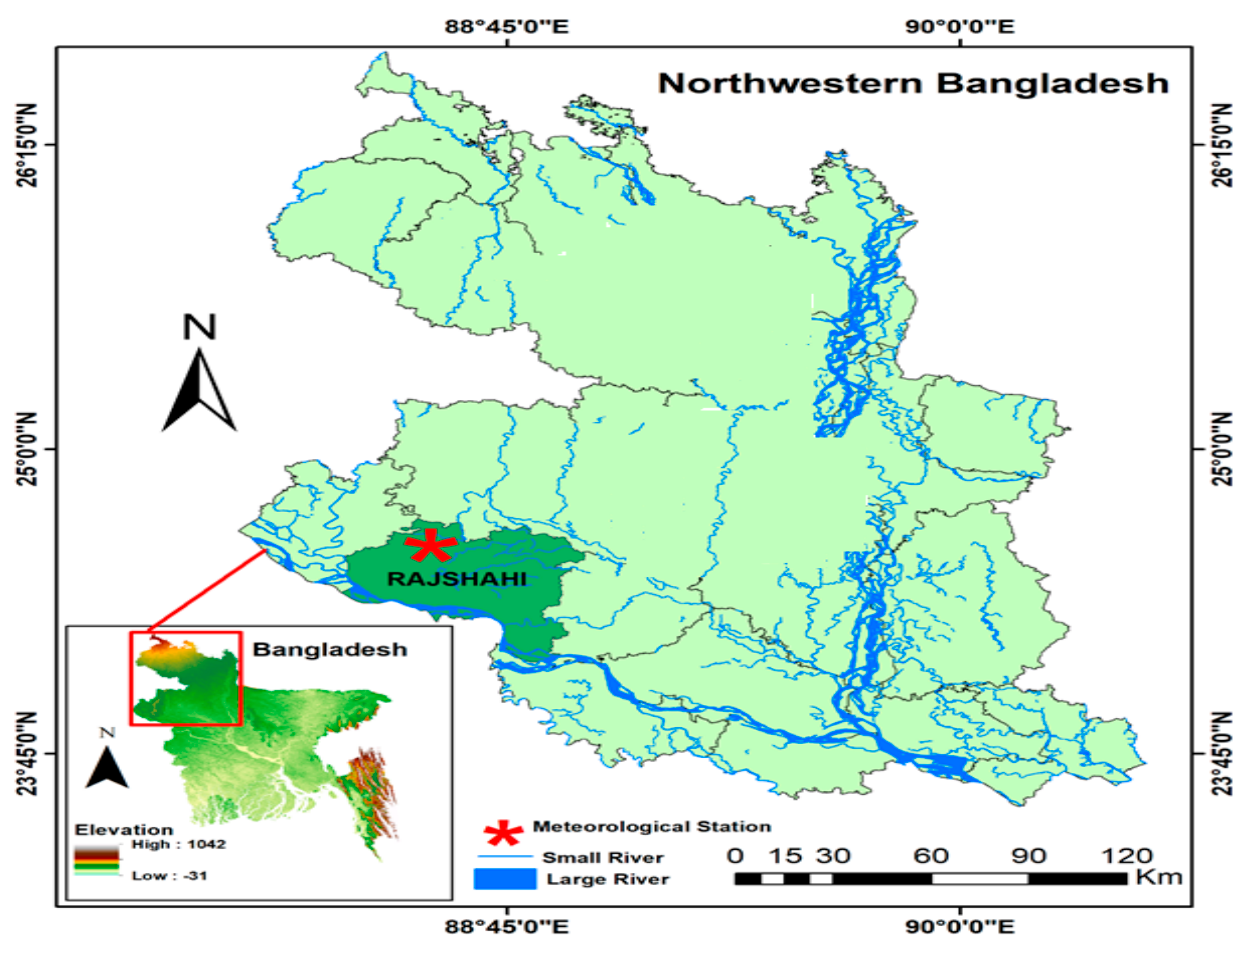
Figure 1. Study area